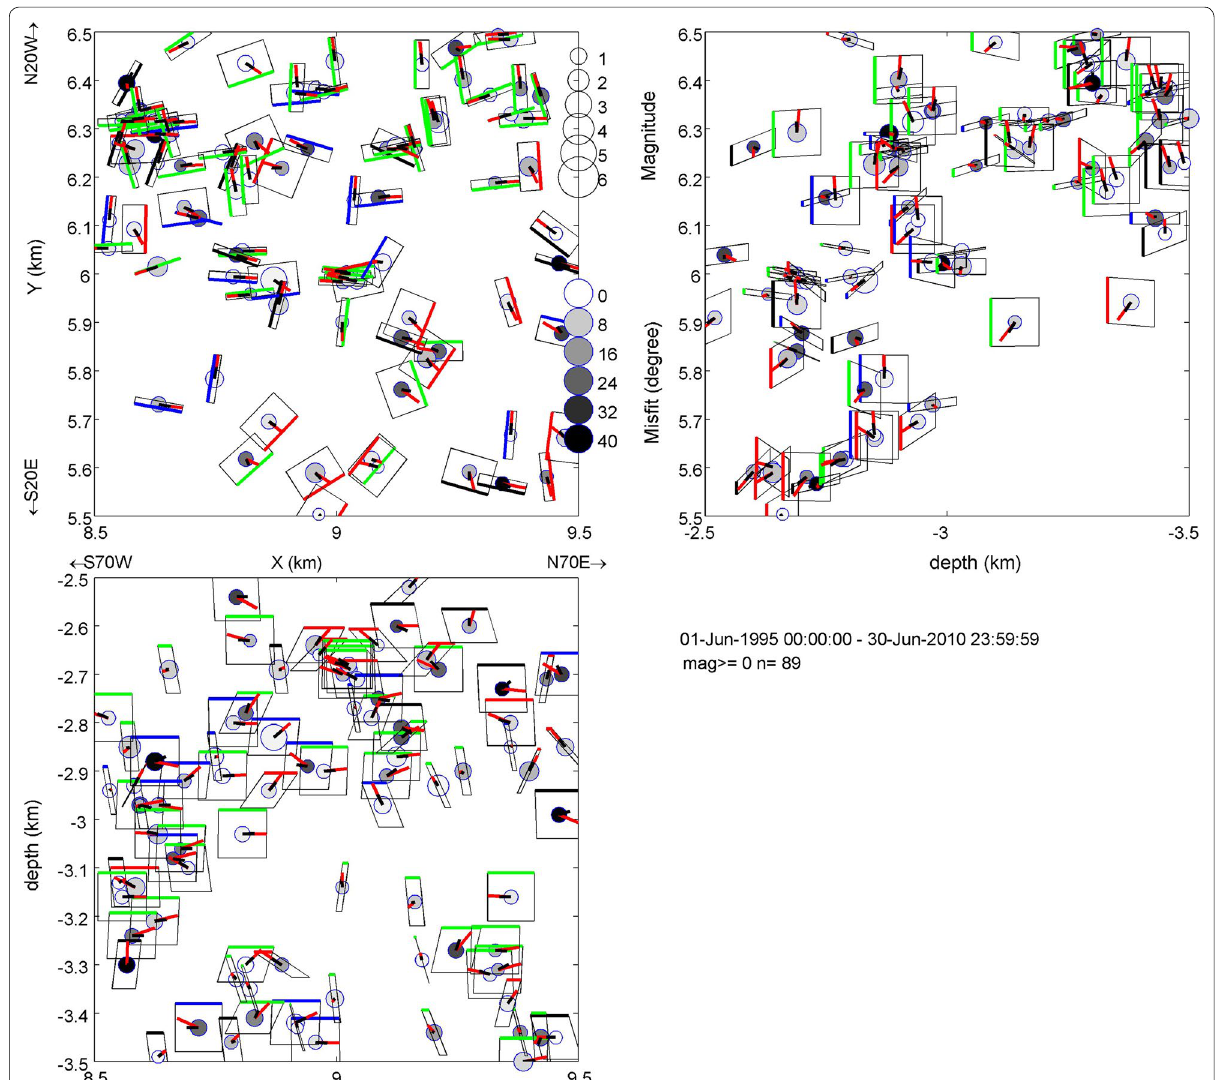
Fig. 11 Results of stress inversion for a grid point ( x